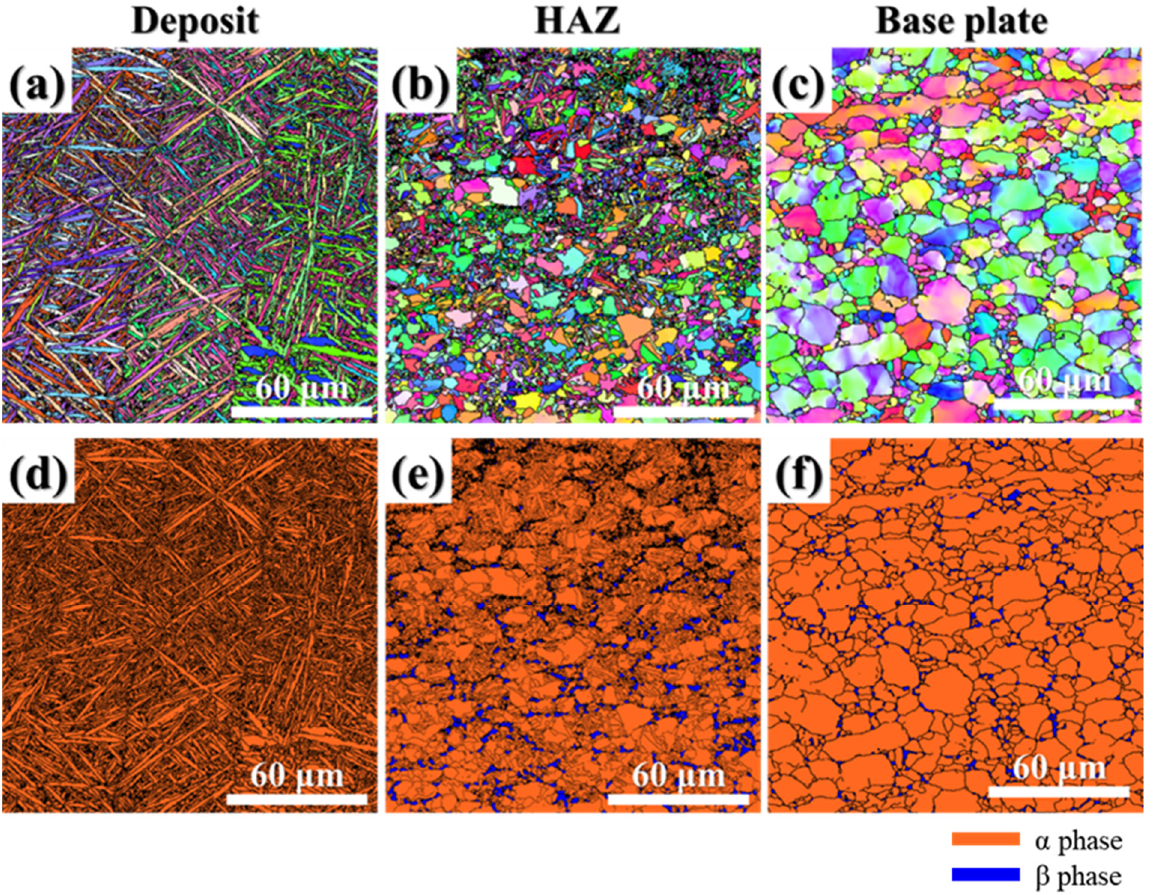
Figure 8. Electron backscatter diffraction–inverse pole figure ( a – c ) and phase maps ( d – f ) of the as-direct energy deposition- processed Ti–6Al–4V alloy taken from the deposition region, heat-affected zone (HAZ), and base plate, respectively.